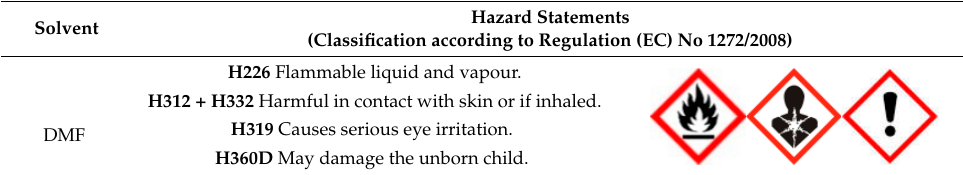
Figure 1. Molecular structure of TEP.